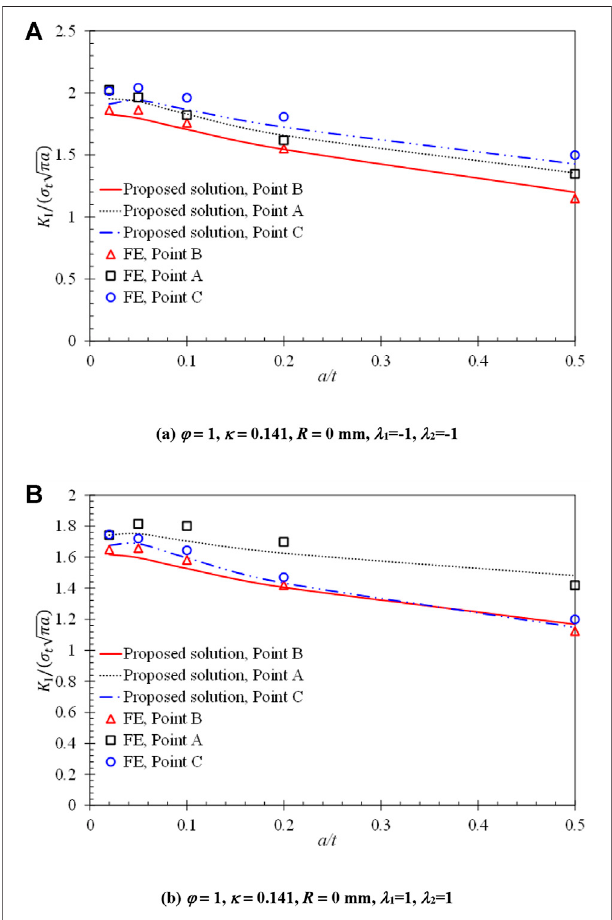
FIGURE 13 | Comparison of SIF results under combined